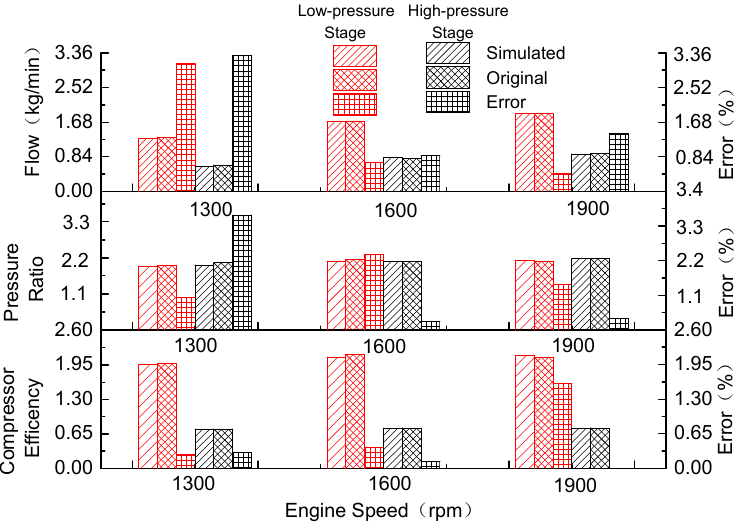
Figure 12. Comparison between results of low-pressure stage and high-pressure stage turbochargers.